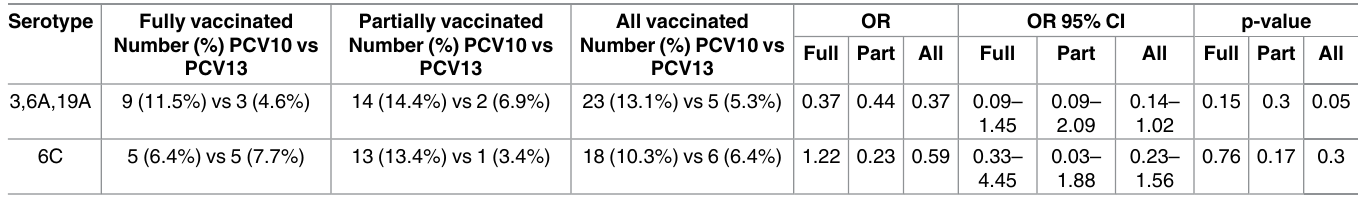
Table 3. Comparison of prevalence for PCV13 additional serotypesand 6C among different vaccinated groups (PCV 10 vs PCV13). Serotype